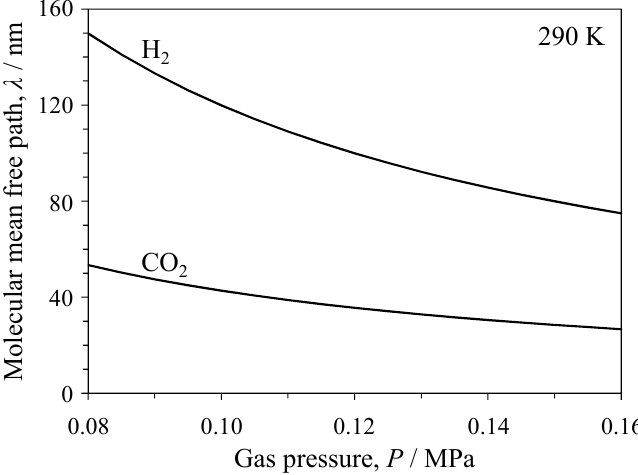
Figure 1. Molecular mean free paths of H 2 and CO 2 molecules as a function of gas pressure.